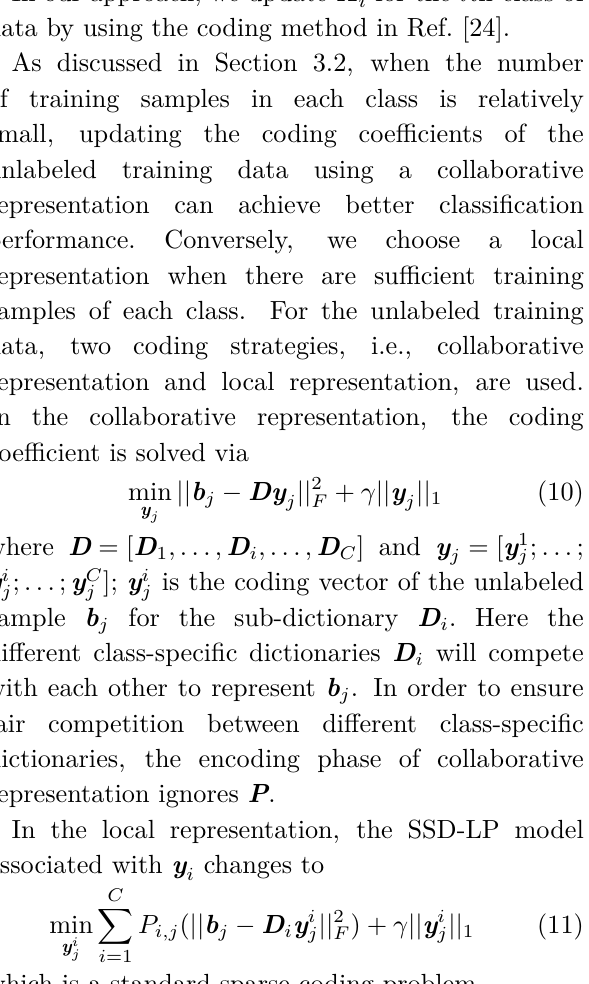
Algorithm 2. The algorithm converges since the total objective function value in Eq. (1) decreases in each iteration. Figure 1 shows the total objective function value for the AR dataset [37]. In all the experiments less than 10